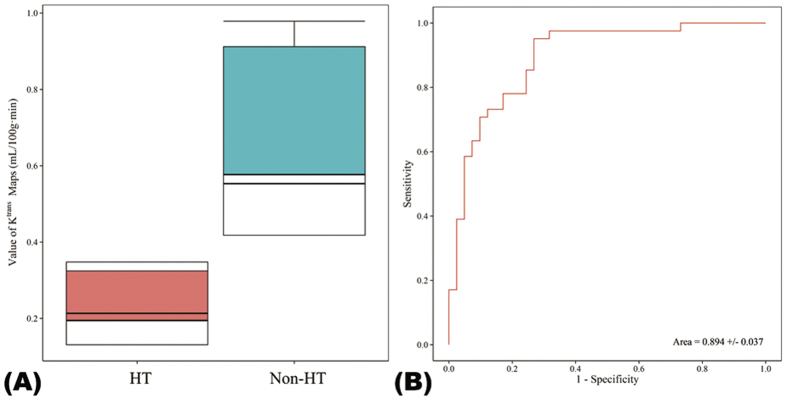
Box plots of Ktrans values of hemorrhagic transformation (HT) and Non-HT regions and the Ktrans receiver operating characteristic (ROC) curve.(A) Box plots of Ktrans values in HT and Non-HT regions. In each box, the median, 95% confidence interval (CI), and first and third quartile values are illustrated. (B) An optimal cutoff value of Ktrans to predict HT was identified using the ROC curve analysis.